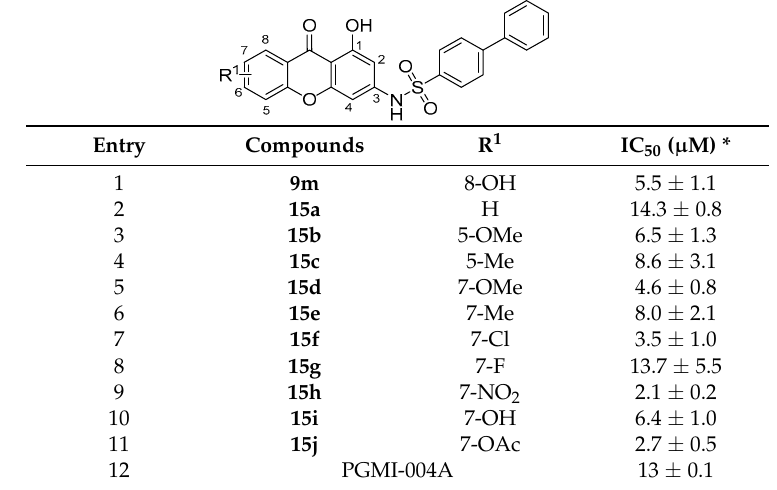
Table 2. Inhibitory activities of 15a – 15k against PGAM1.